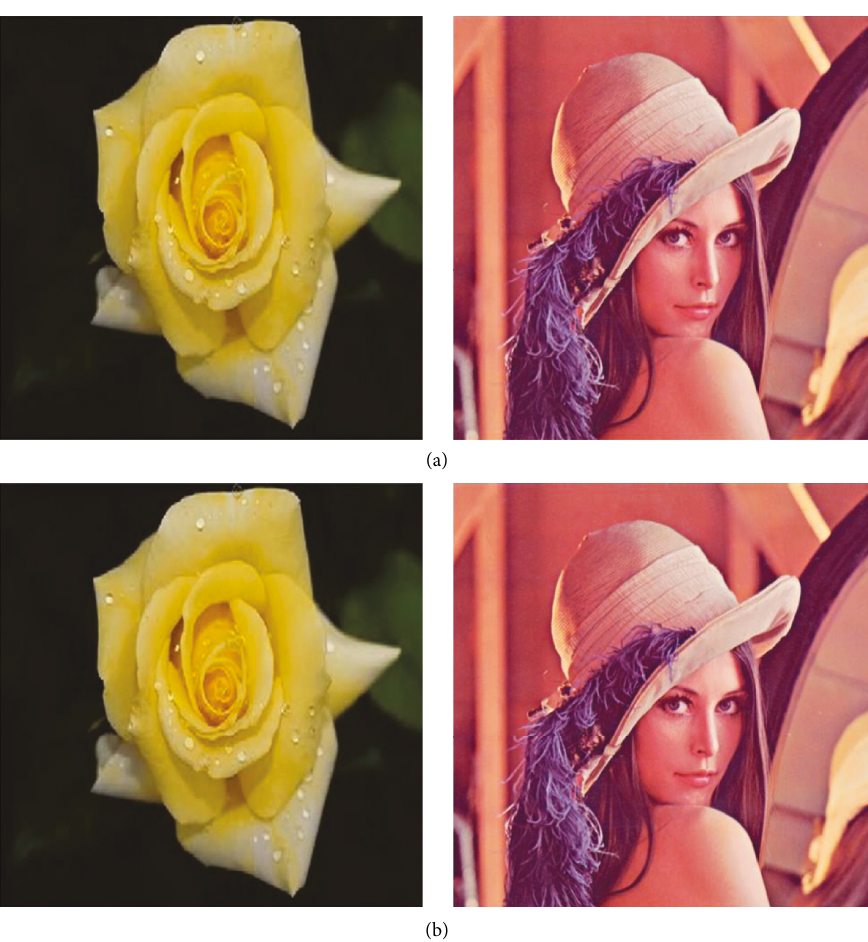
Figure 11: (a) Cover and (b) stegano images.